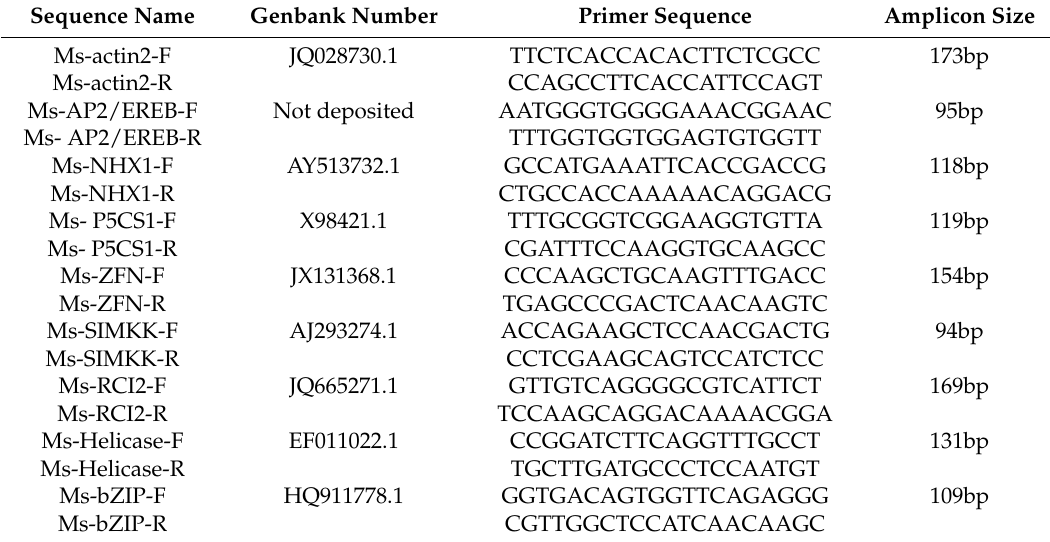
Table 1. The set of primers used for qPCR experiments ( Msactin2 , MsAP2/EREB , MsNHX1 , MsP5CS1